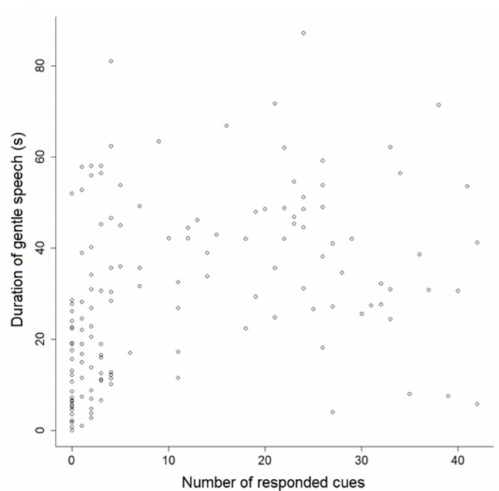
Figure 5. Dispersion of the number of cues responded to by shelter and companion dogs per training session as a function of the duration of trainers’ gentle